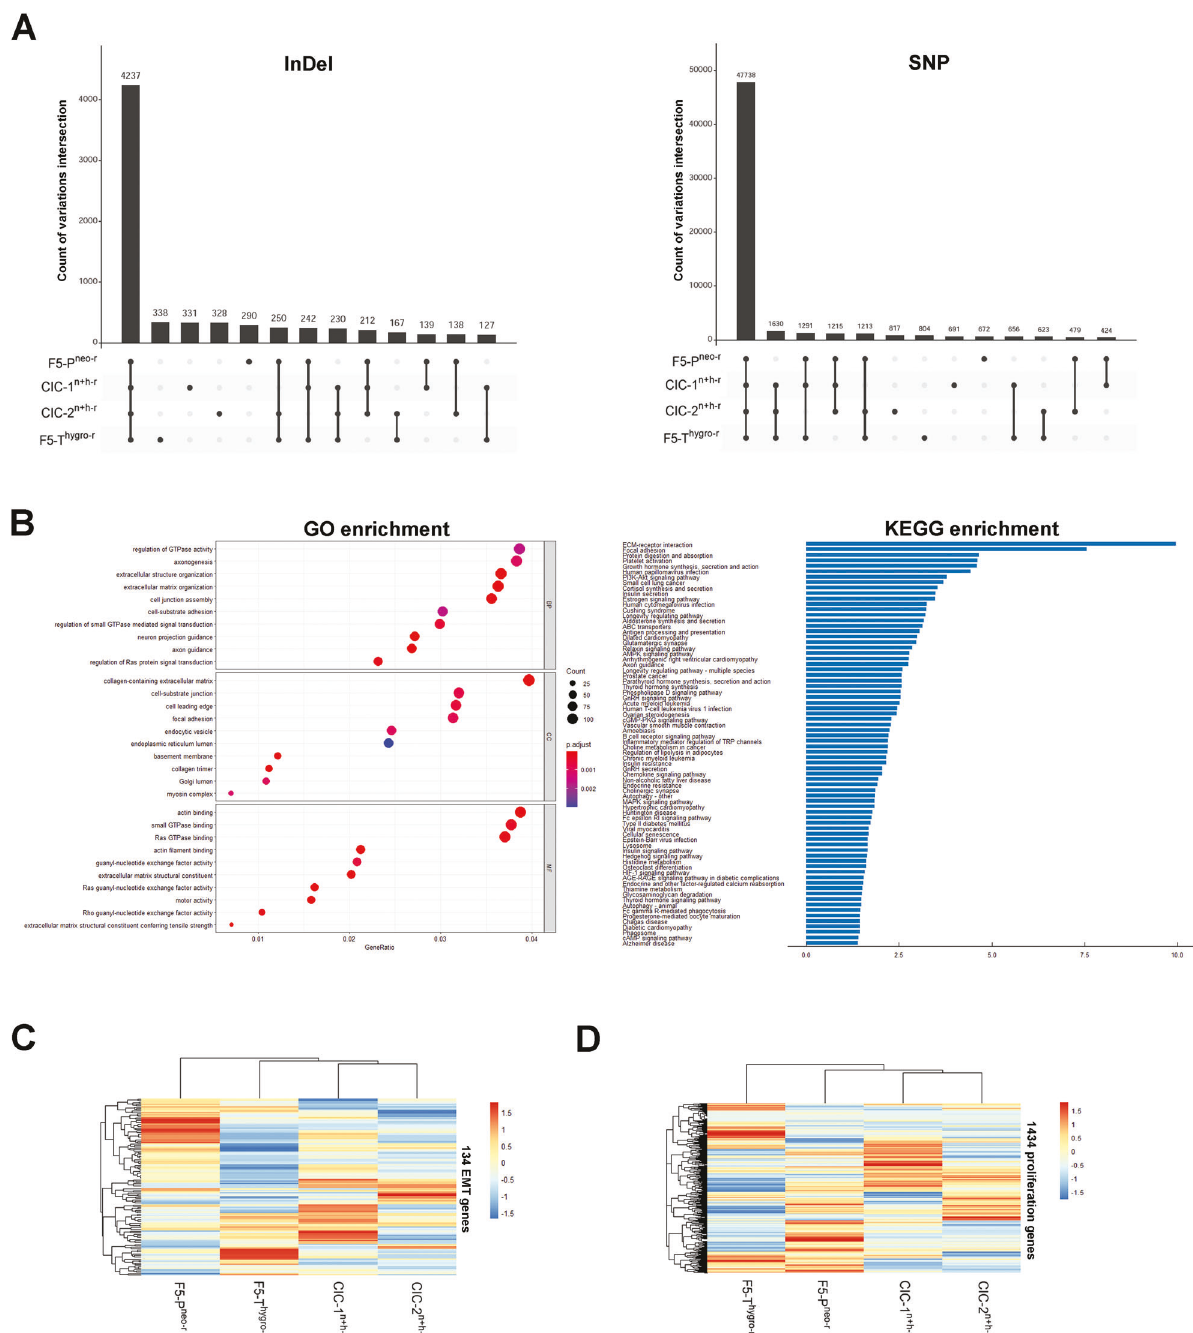
Fig. 7 Bioinformatic analysis of gene transfer in CIC derivatives. A Upset plot of germline InDels and SNPs identi fi ed in F5-P neo-r , F5-T hygro-r , CIC-1 n + h-r and CIC-2 n + h-r cells. The intersection is represented by the bottom plot, and their occurence is shown on the top barplot. The black dots connected by lines show which variations set is part of an intersection. The number of shared variations (6051) by one or both CIC derivatives and parental cells is summed up by intersection amounts highlighted by red boxes. B GO and KEGG enrichment analysis of 3796 genes harboring above 6051 shared variations. Cluster analysis and heatmap plotting of the ( C ) EMT- and ( D ) proliferation-associated gene expression measured by RNA-seq in F5-P neo-r , F5-T hygro-r , CIC-1 n + h-r and CIC-2 n + h-r cells. parental cells to daughter cells. This analysis showed that a total Detection of gene transfer in CIC derivatives by whole-exome of 6051 variations (including SNP and InDel) located in 3796 sequencing (WES) genes, were shared by one or both CIC derivatives and parental To further investigate whether gene transfer by CICs contribute to cells (Fig. 7A, Supporting Table), implying that DNA transfer might the malignancy acquisition, a WES assay was performed with the occur in these gene loci of daughter cells. Importantly, enrichment parental and daughter cells. The unique germline variations analysis revealed that these genes were signi fi cantly enriched in between the two parental cells were used as DNA makers to growth- and metastasis-related process and pathways, including detect the potential genomic regions that transferred from